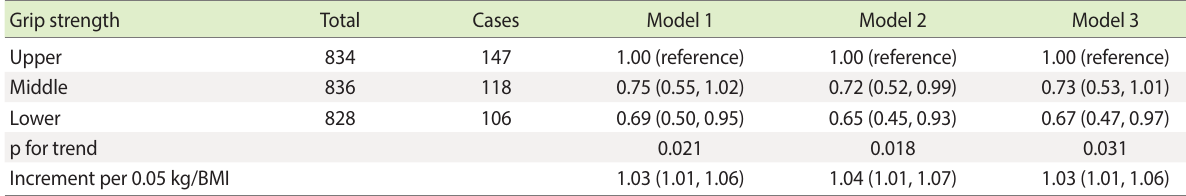
Table 2. Associations between grip strength and glycemic control 1 Grip strength